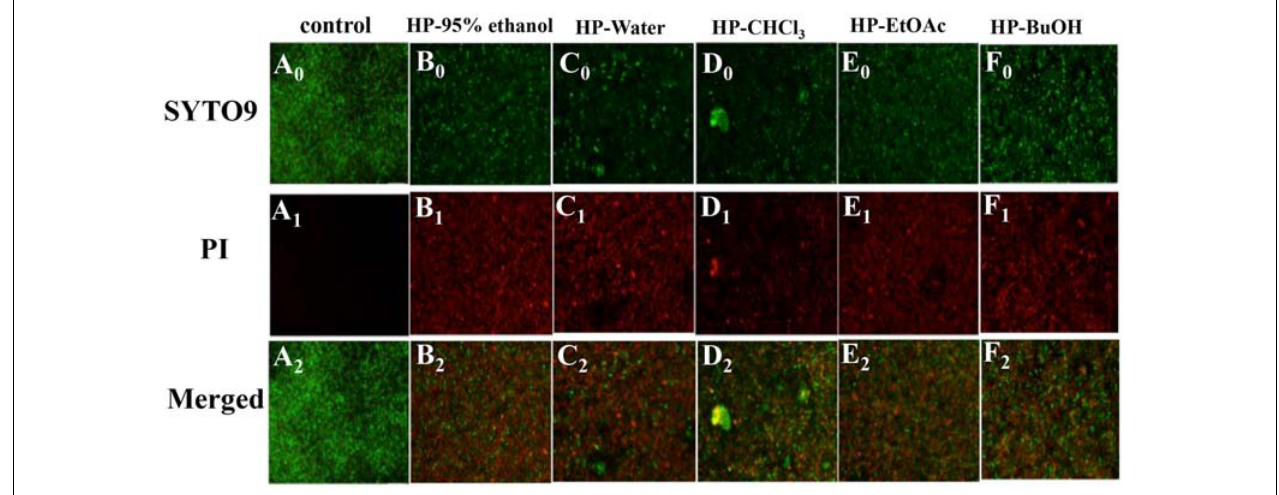
FIGURE 6 | Effects of B. crassifolia leaf extracts on S. mutans ATCC25175 biofilm by using a fluorescence microscope. Live cells exhibited green fluorescence (SYTO 9), whereas bacteria with damaged membranes exhibited red fluorescence (PI). (A) control; (B) HP-95% ethanol; (C) HP-Water; (D) HP-CHCl 3 ;